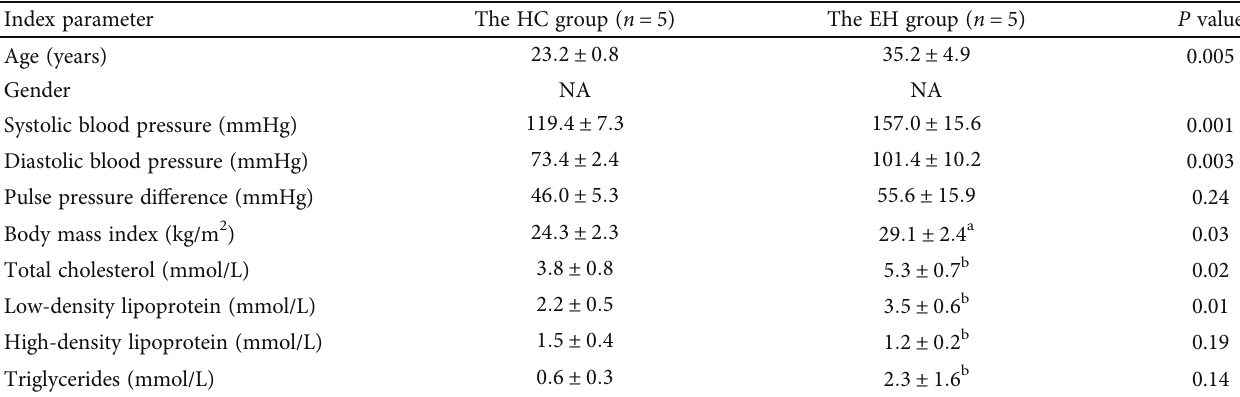
Table 1: Basic characteristics of